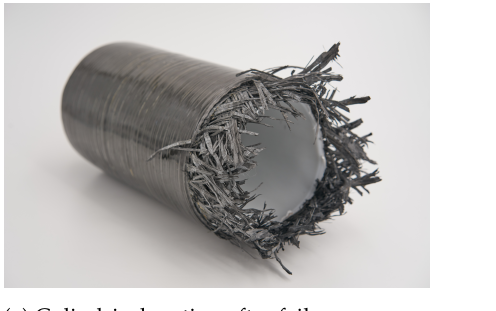
( a ) Cylindrical section after failure. Figure 16. Failure mechanism of the pressure vessel. Failure pressure of 113.4 MPa. One of the reasons for the failure could be the secondary stress at the dome-cylinder interface. The influence of the metallic boss present in this case is not considered; however, it cannot be